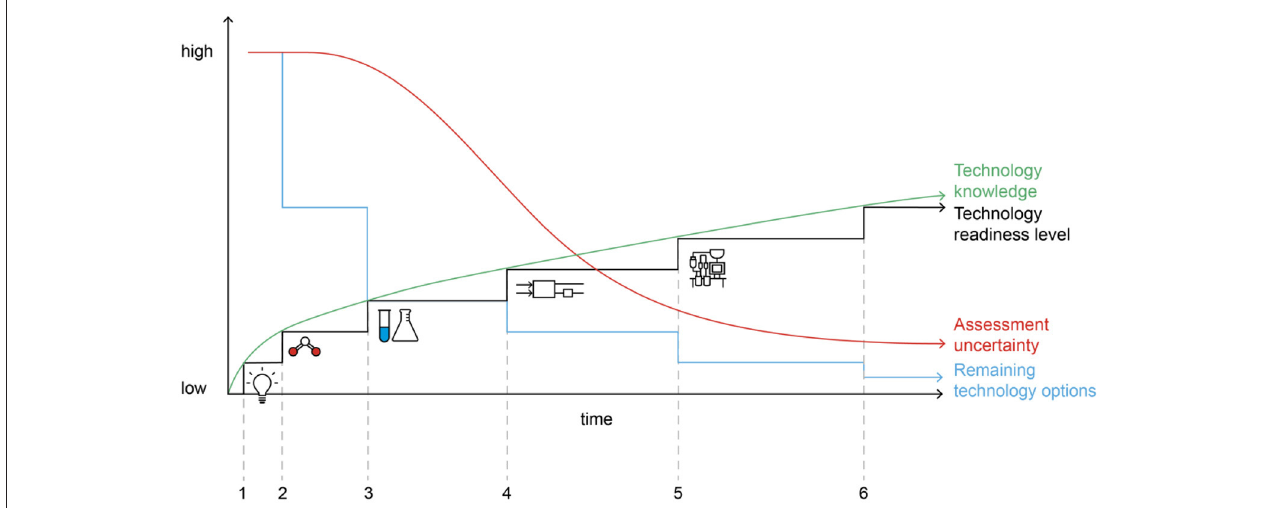
FIGURE 2 | The schematic relationship between technology knowledge, TRL, assessment uncertainty, and remaining technology options. As a result of ongoing R&D, technology knowledge advances, and the next TRL or stage-gate is reached. TEA, and LCA support decision-making at each TRL or stage-gate, filtering out unpromising technology options, decreasing remaining technology options, and reducing assessment